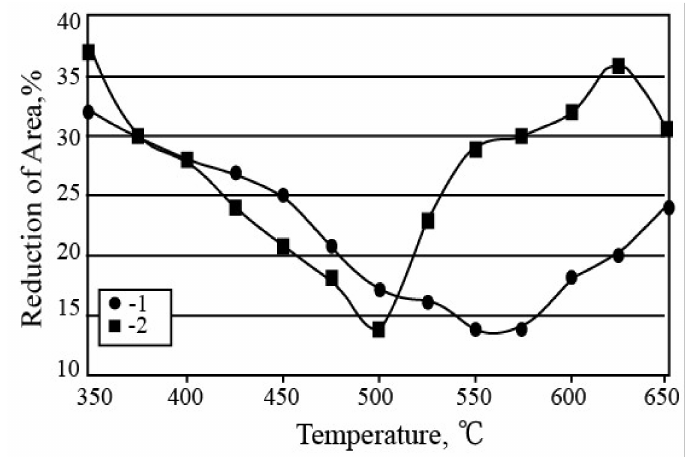
Figure 5. Reduction of area versus test temperature for a CuNi25 alloy after deformation with strain . . ε = 2.7 × 10 − 1 s − 1 and 2. ε = 2.7 × 10 − 3 s − 1 . Reprinted from ref. rates: 1.